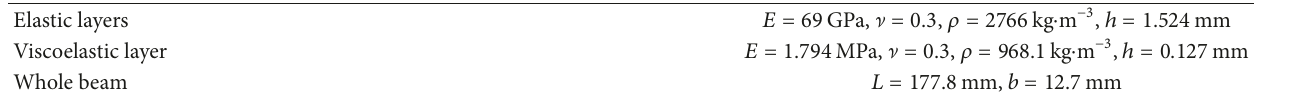
Table 5: Material and geometrical properties.